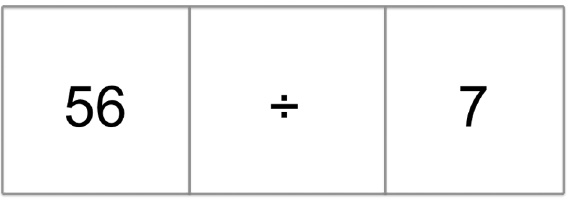
Figure 1. The three interest areas superimposed over an example